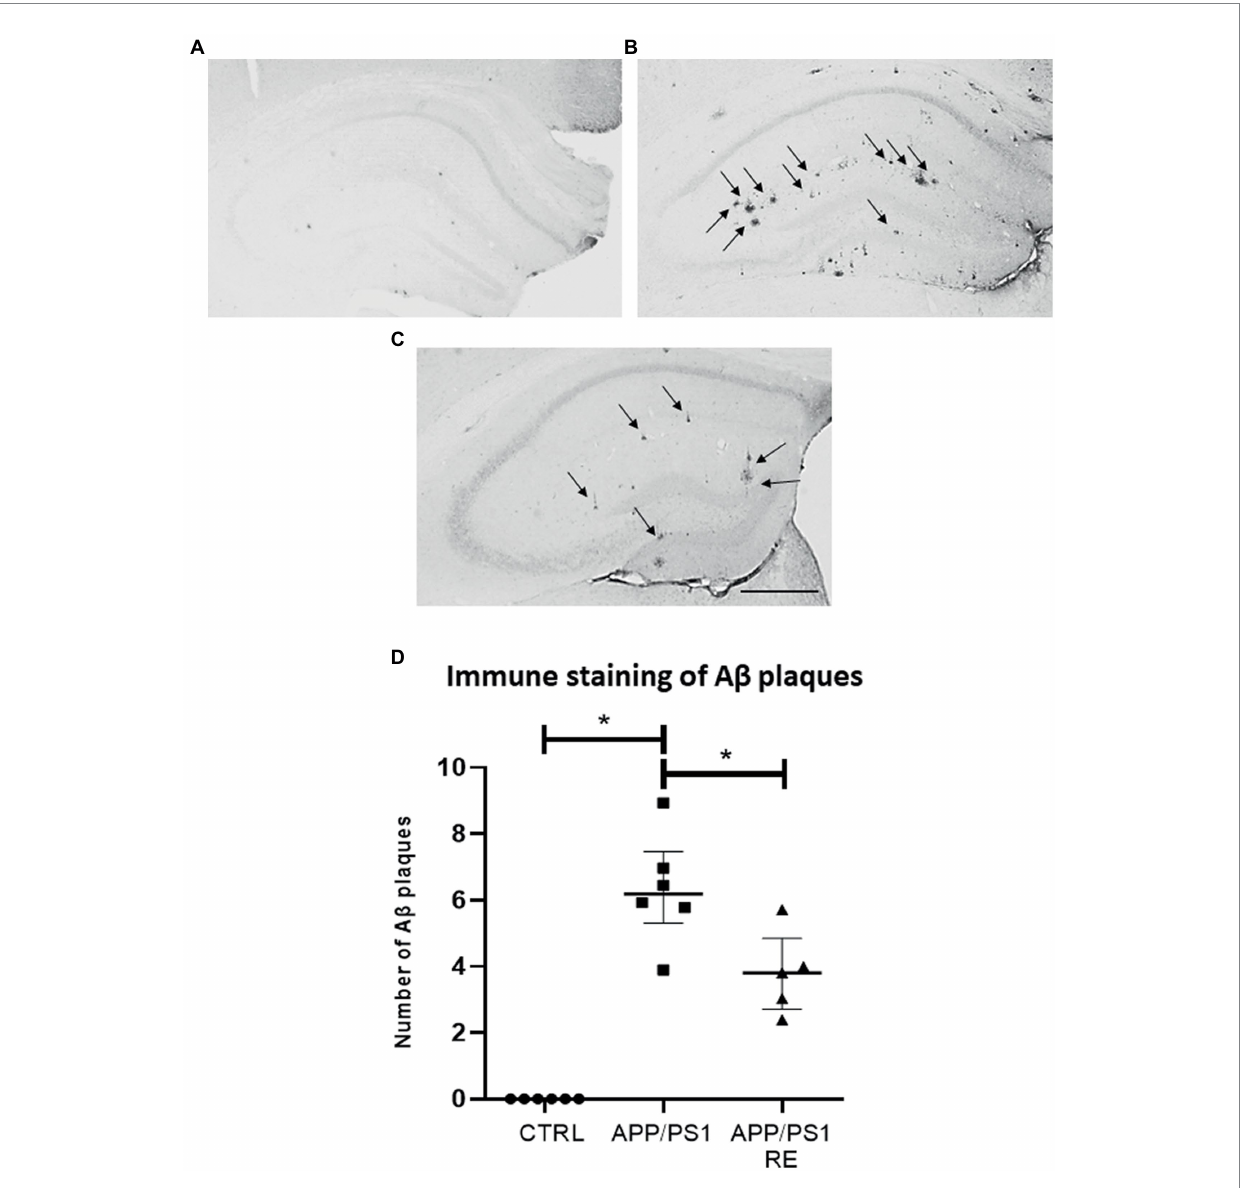
FIGURE 2 Resistance exercise reduced the number A β plaques in the hippocampus of APP/PS1 mice. Representative photomicrographs (scale bar = 40 μ m) showing A β plaques (arrows) in hippocampal sections of mice from CTRL (A) , APP/PS1 (B) , and APP/PS1 + RE (C) groups. Graph values (mean ± standard error of the mean) represent the number of A β plaques labeled with 6-E10 (D) . Asterisks indicate significant differences between groups (* p < 0.05; one-way ANOVA followed by the Dunnett’s posttest), n = 5–6